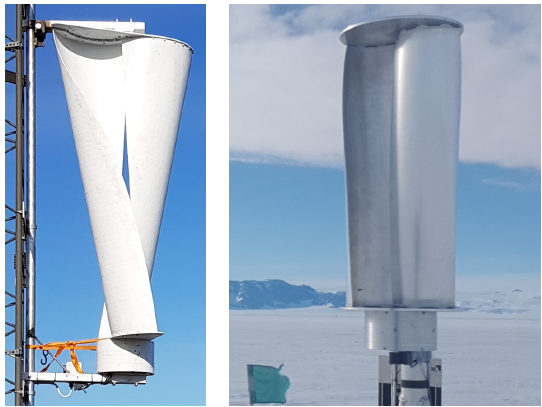
Figure 3. Studied turbine prototypes: SAWINT ( left ) and SAVANT ( right